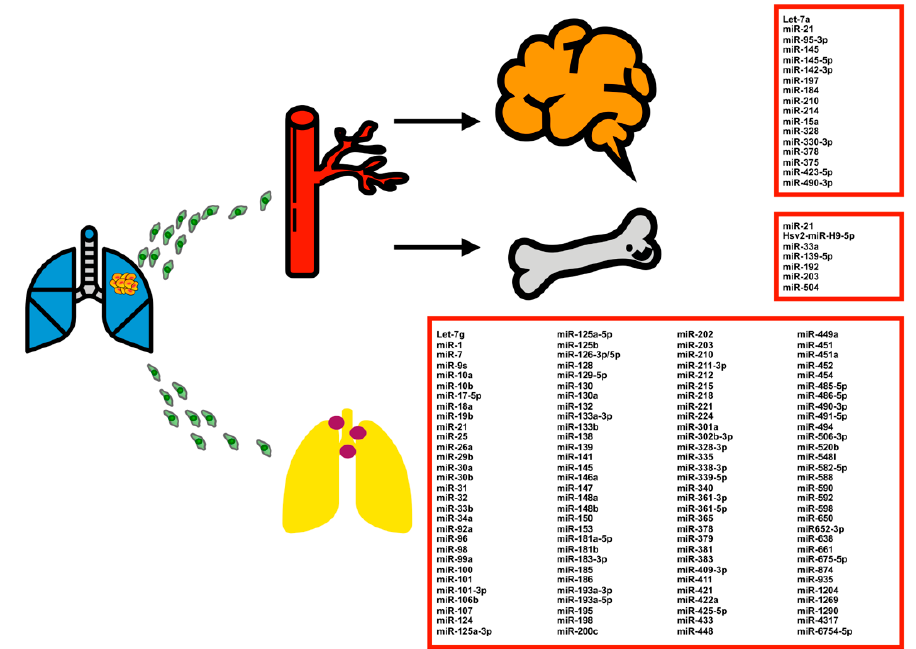
Figure 2. MiRNA expression profiling in NSCLC associated with brain, bone, and lymph node metastasis.